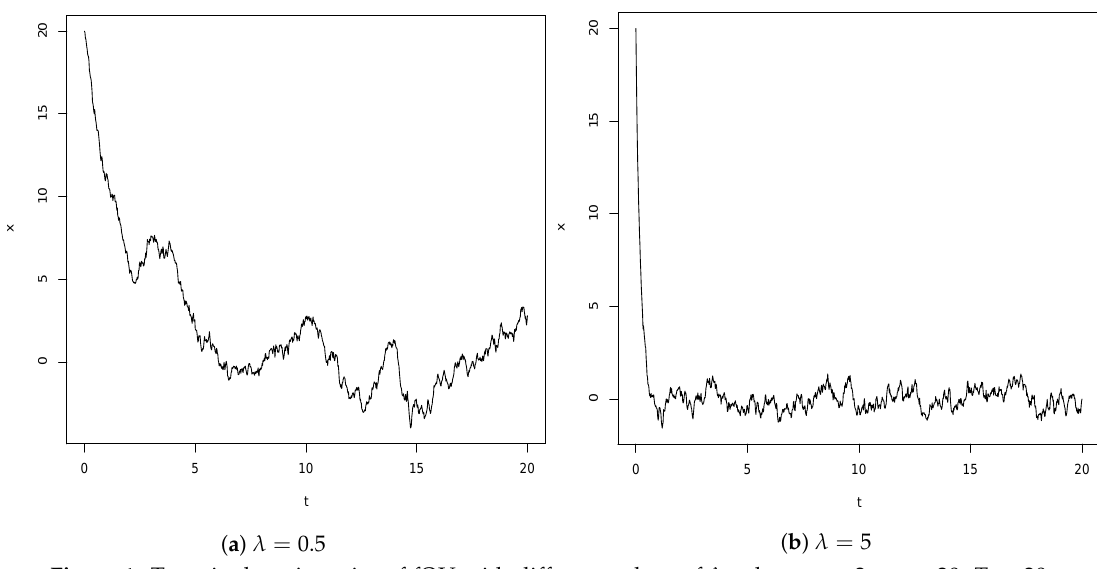
Figure 1. Two single trajectories of fOU with different values of λ , where σ = 2, x 0 = 20, T = 20, H =